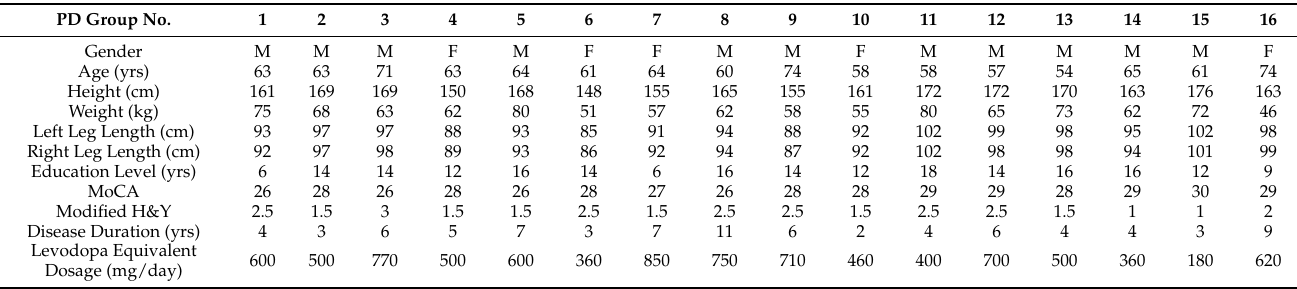
Table 2. Clinical characteristics of Parkinson’s